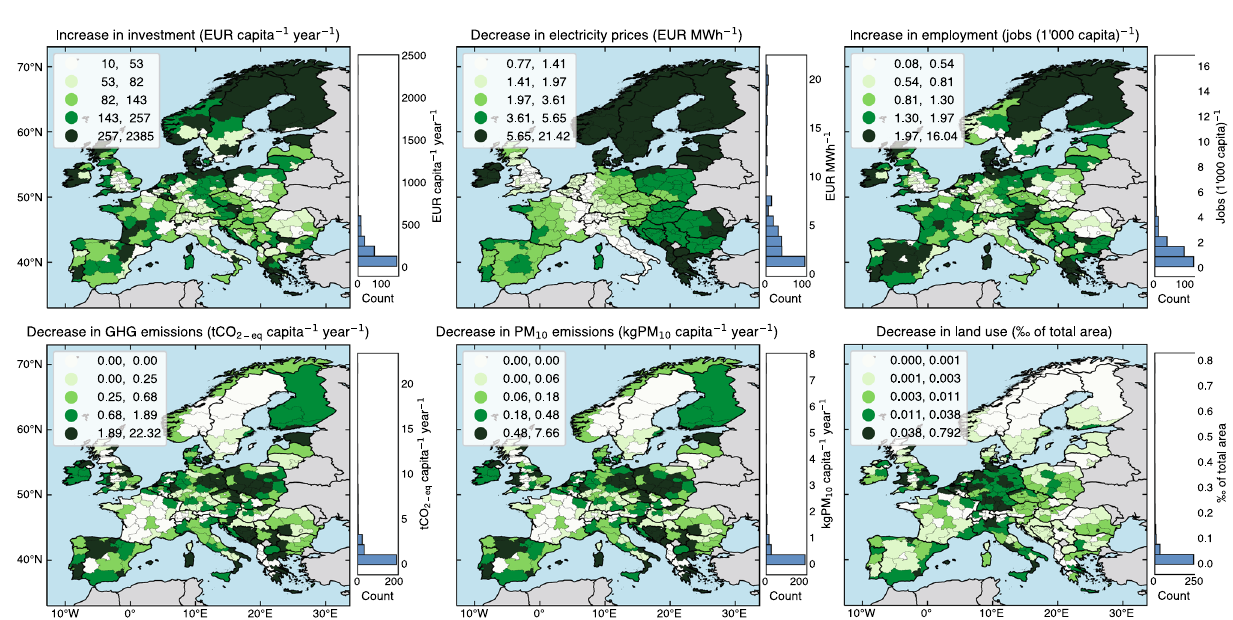
Fig.3|Mapsofscenarioaveragesofregionalelectricitysectorbene fi tsin2035. These maps show the average regional bene fi ts associated with low-carbon elec- tricitysectoracross248MGAscenariosandtheminimumcostscenario,whichhave improvedimpacts(bene fi ts),ascomparedtothescenariooffrozengenerationand storage capacity. The color legend uses a quantile classi fi cation scheme so that